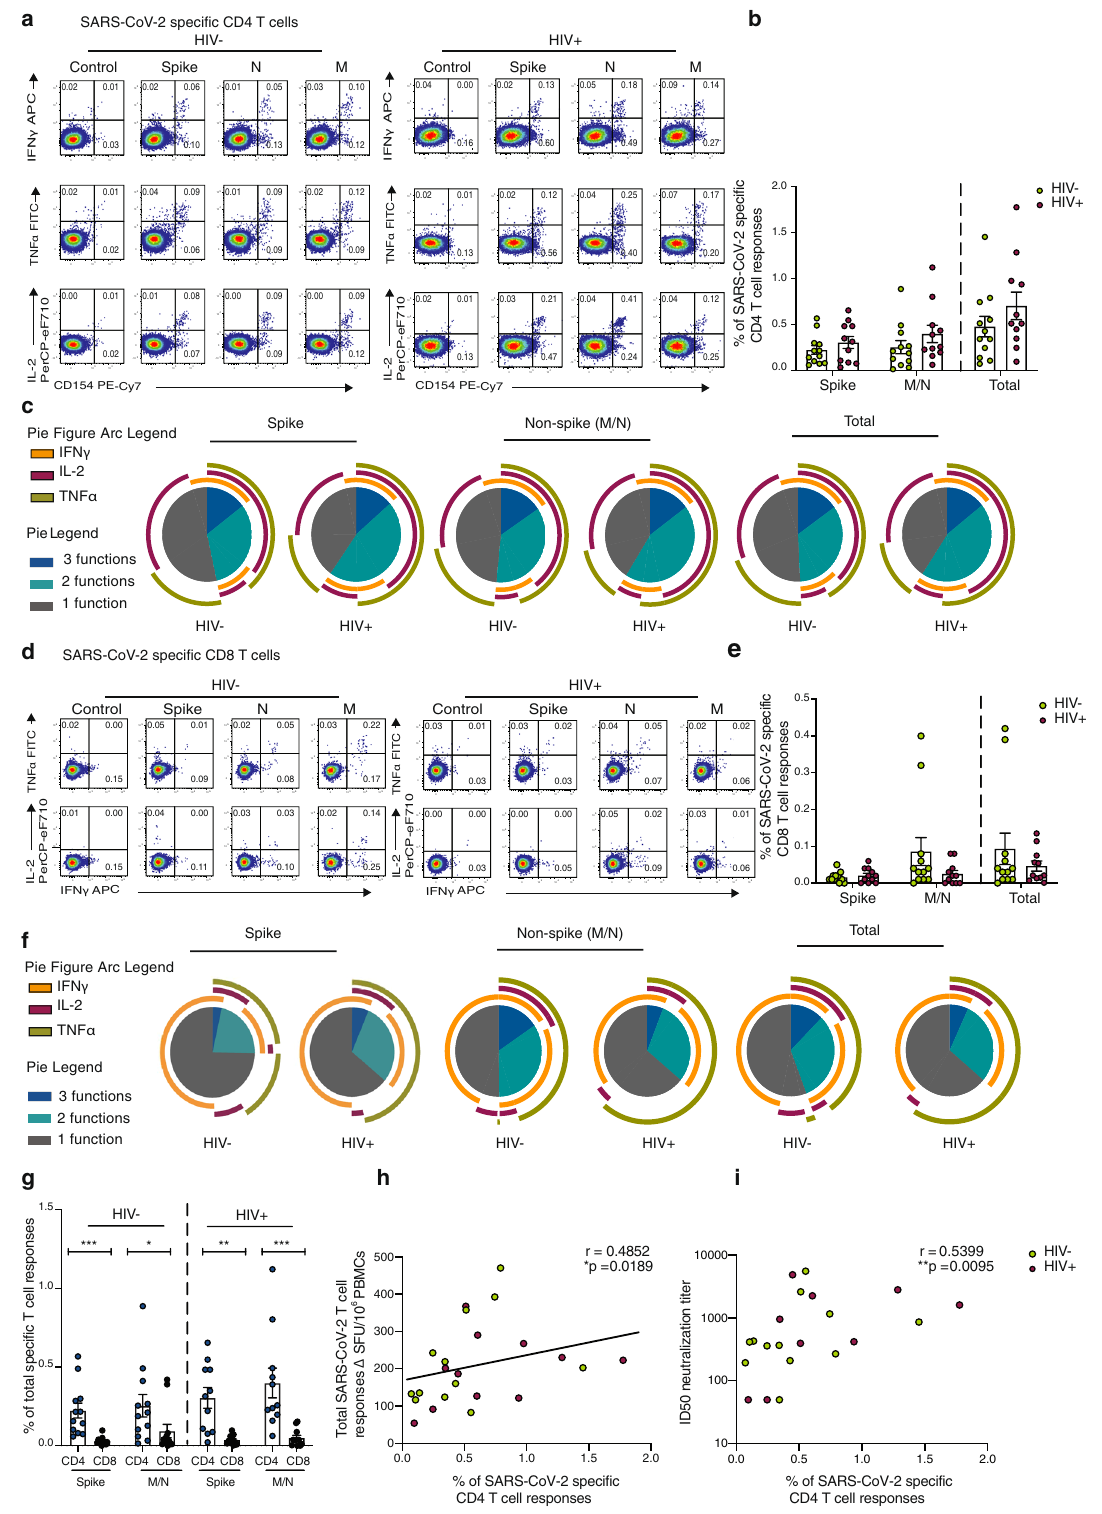
Pie Figure Arc Legend IFN